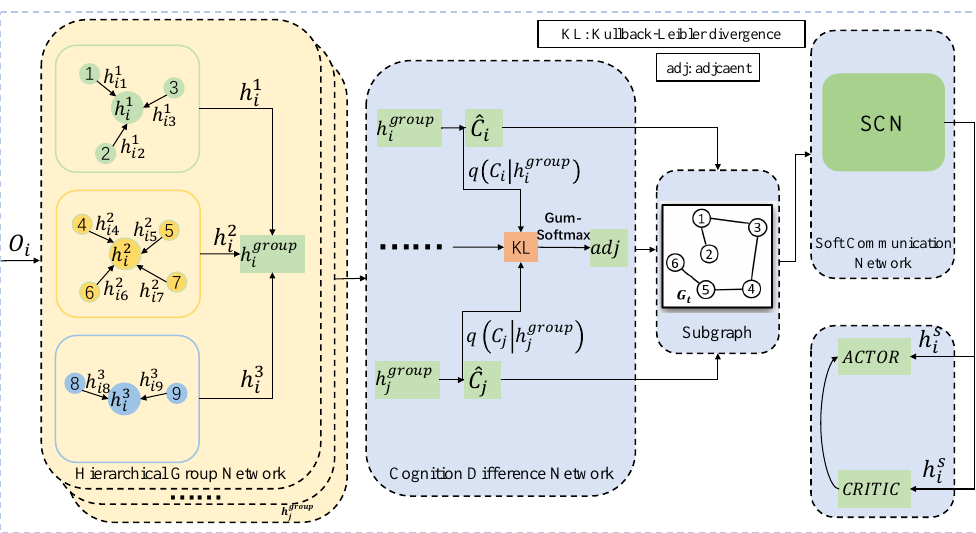
Figure 1. Architecture of MA-HCDP. Suppose there are nine entities around agent i . HGN divides the entities into different groups and adopts attention mechanism to extract high-dimensional state representations. Then, CDN is responsible for filtering irrelevant agents to reduce redundant information. Next, the remaining agents are modeled as a graph G . SCN is responsible for the weight distribution of the remaining agents. Finally, the captured states of different groups are subsequently used to update critic and actor